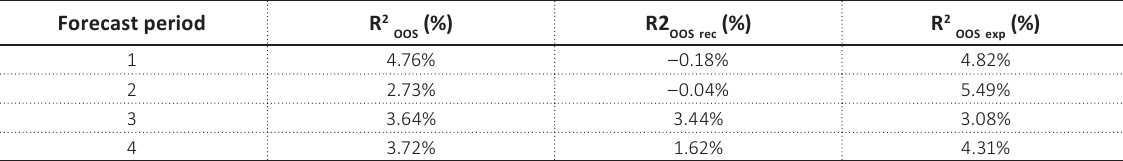
Figure 4. The sentiment coefficient for a 50-month rolling window returns forecast from 1999–2018, for horizons 0 to 4 with Newest t Table 3. Out-of-sample forecasting results